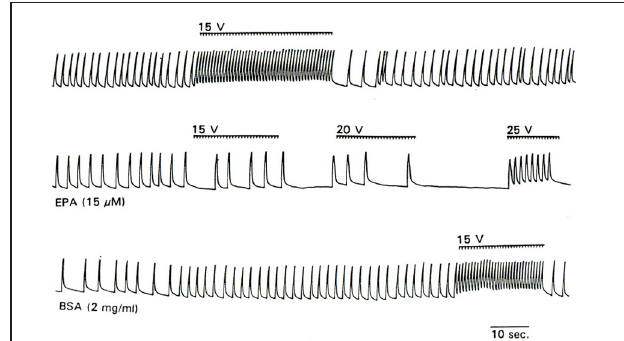
FIGURE 2 | Effect of EPA on the response of cultured myocytes to electrical pacing. Trace shows the response of cell contraction to the electrical stimuli (as indicated by the bars above the contraction trace) before perfusion with EPA (top trace), during perfusion with 15 µ M EPA (middle trace) and after washout with BSA.